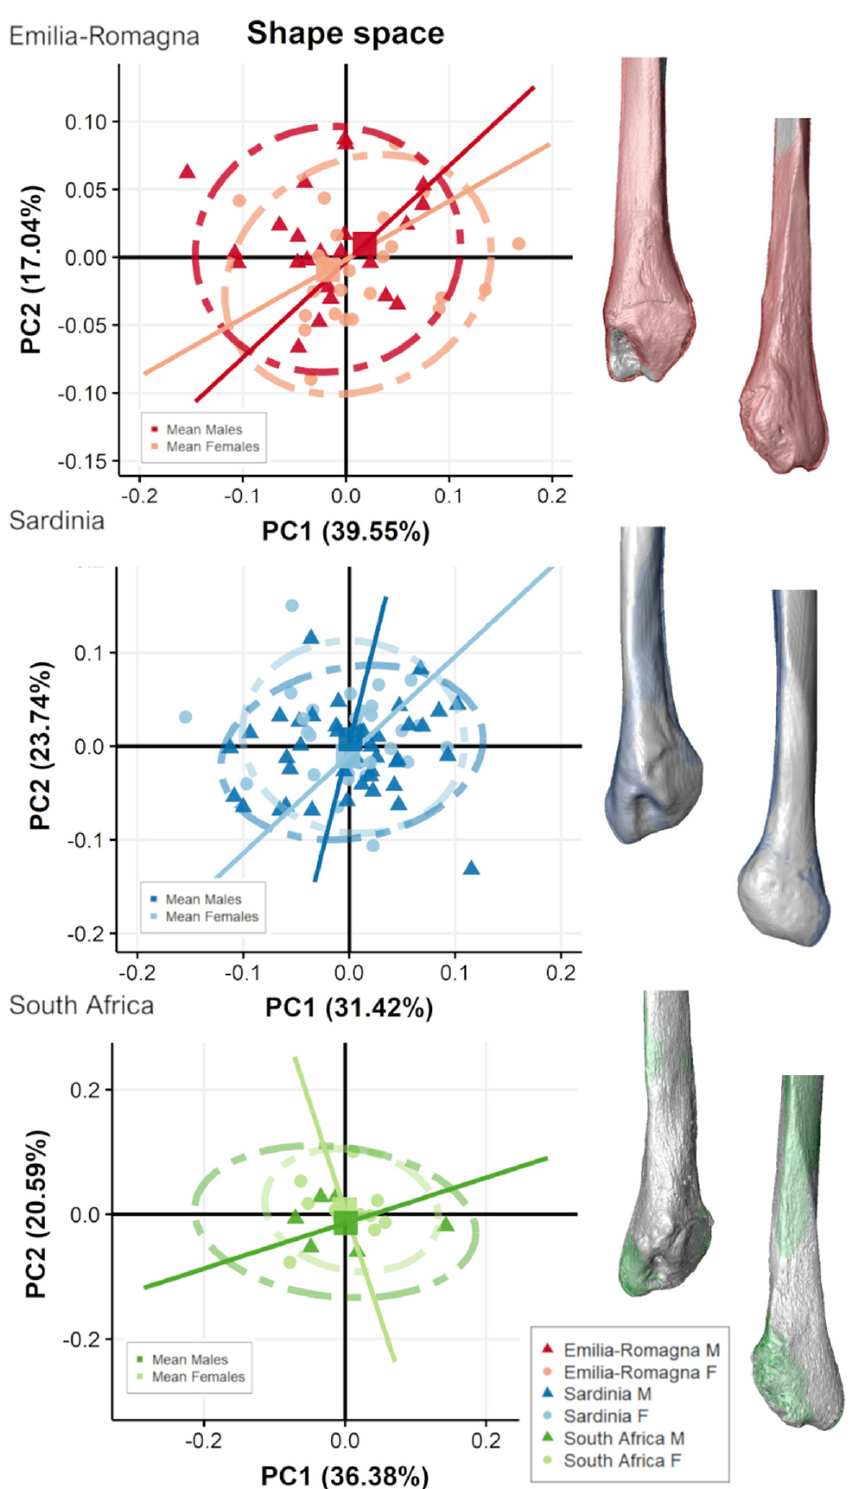
Figure 6. Scatterplot of shape-space PC scores of distal fibular epiphyses for the two Italian (Emilia- Romagna and Sardinia) and the South African populations, divided by sex groups and presenting mean male (colored) and female (grey) shape variation along the PC axes, represented in the scatterplot as squared dots, in medial ( top ) and lateral ( bottom ) views. Lines represent allometric trajectories for males and females for each population.